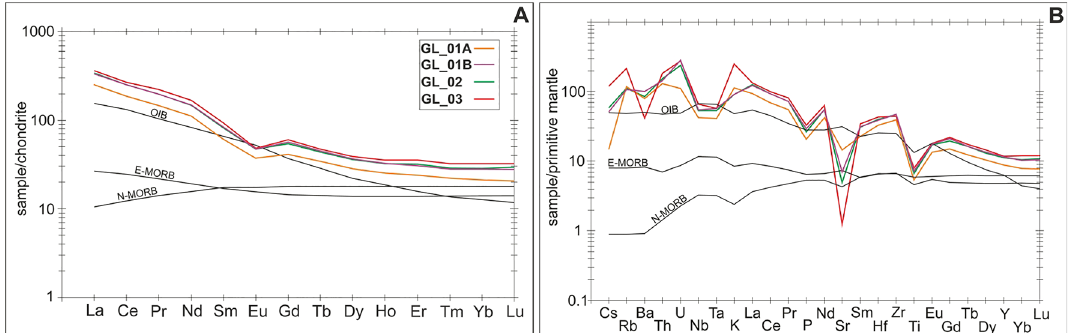
Figure 14. ( A ) Chondrite-normalized REE patterns and ( B ) primitive mantle-normalized multi-element diagrams for trachyandesites from Głuszyca (note the curves for samples GL_1A, GL_01B, and GL_02 represent average composition of two analyses per sample — see Table 10). Normalization values are after 84 . The curves for OIB, N-MORB, and E-MORB basalts were included. For detailed description of particular samples and their alteration style, the reader is referred to Table